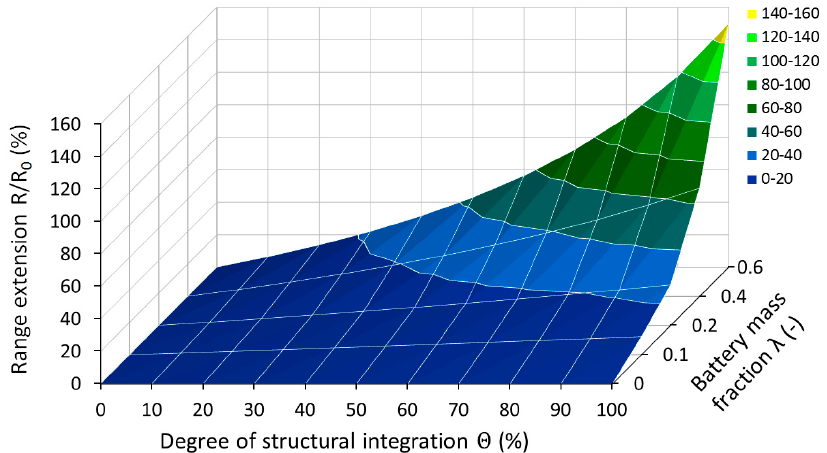
Figure 3. Theoretical aircraft cruise range extensions enabled by multifunctional energy-storing composites in dependence on the degree of structural integration and the ratio of battery and overall aircraft mass.